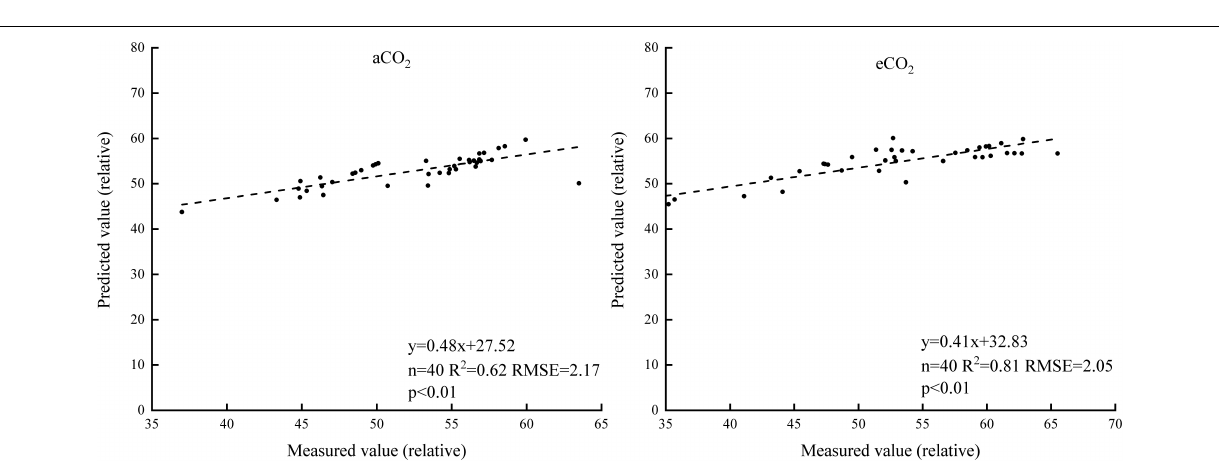
TABLE 3 | Estimation models of the chlorophyll content in wheat canopy based on different spectral indexes. Treatment